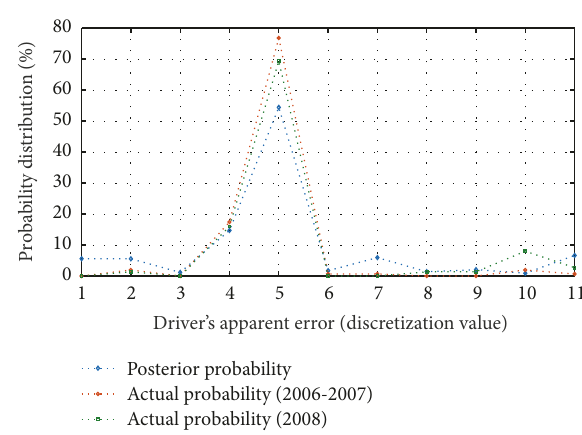
Figure 5: The comparison of posterior and actual probability curves of driver’s apparent error when the evidence variable is “rear end.”